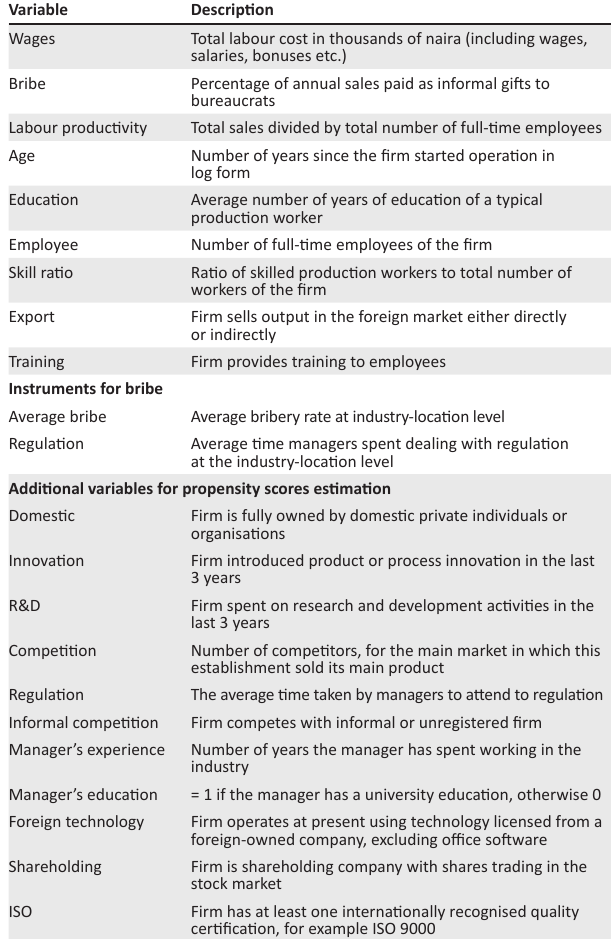
TABLE 1: Variables